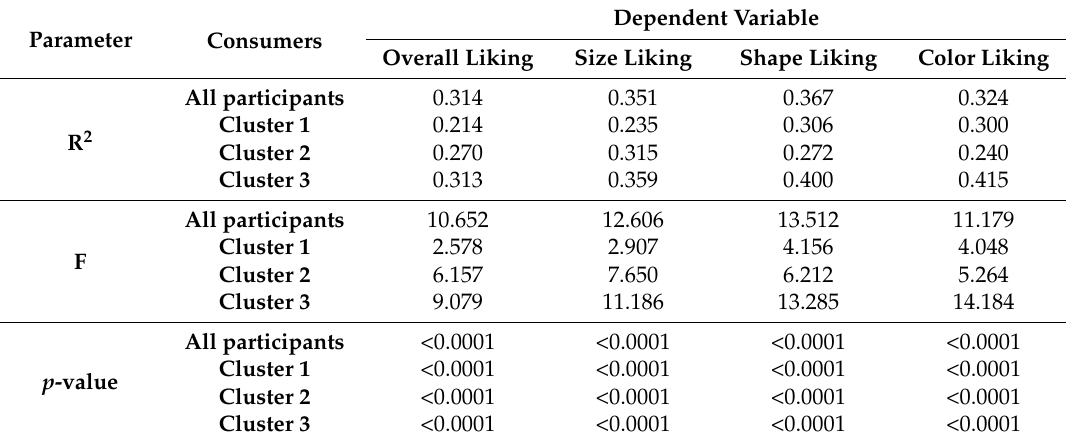
Table 3. Summary of the two-way ANOVA tests for all the participants and for each of the three consumer clusters. Overall Liking, Size Liking, Shape Liking and Color Liking as dependent variables. Sample and Consumer as explanatory variables. A level of significance α = 0.05 was used.